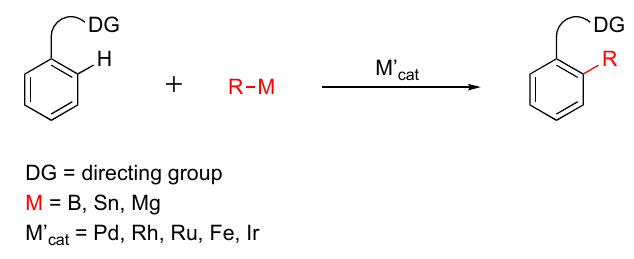
Table 1. Reaction of indium organometallics with 2-( p -tolyl)pyridine under rhodium catalysis 1